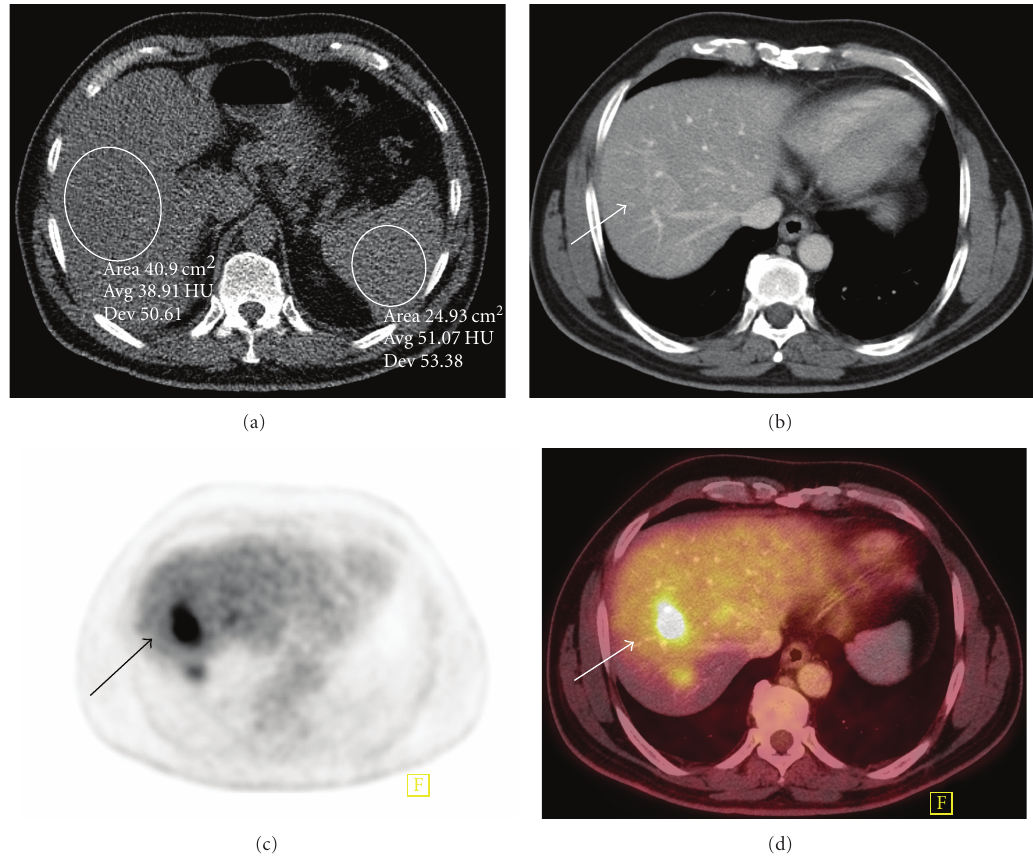
Figure 6: Liver metastatic deposit in a fatty liver that is di ffi cult to appreciate on CT. (a) There is di ff use fatty infiltration of the liver on unenhanced CT with attenuation values in the liver far lower than those of the spleen. (b) There is a very subtle lesion (arrow) in segment 7 on contrast-enhanced CT imaging. (c) There is avid radiotracer uptake (arrow) in the right lobe of liver FDG-PET. (d) Increased uptake on FDG-PET (arrow) correlates with the subtle liver lesion on fused PET-CT consistent with a hepatic